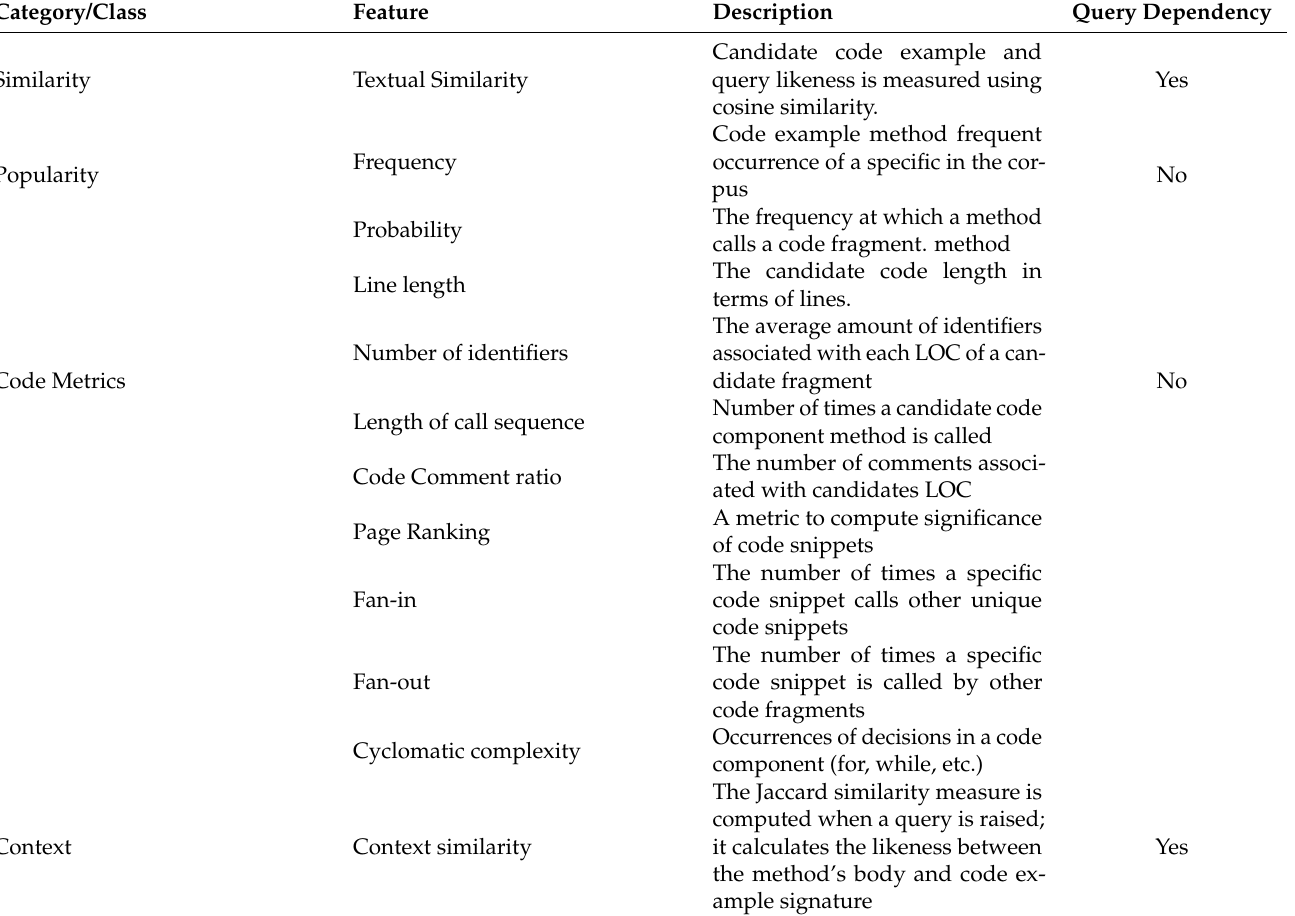
Table 1. Component’s